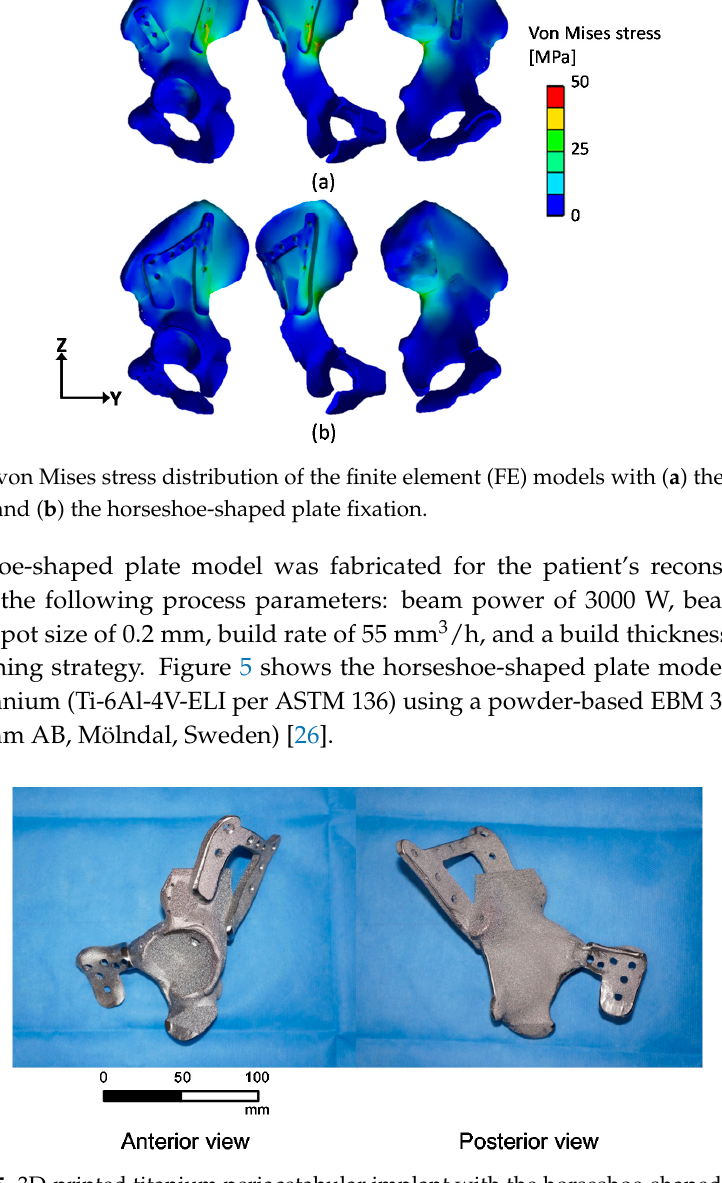
Figure 5. 3D-printed titanium periacetabular implant with the horseshoe-shaped plates.